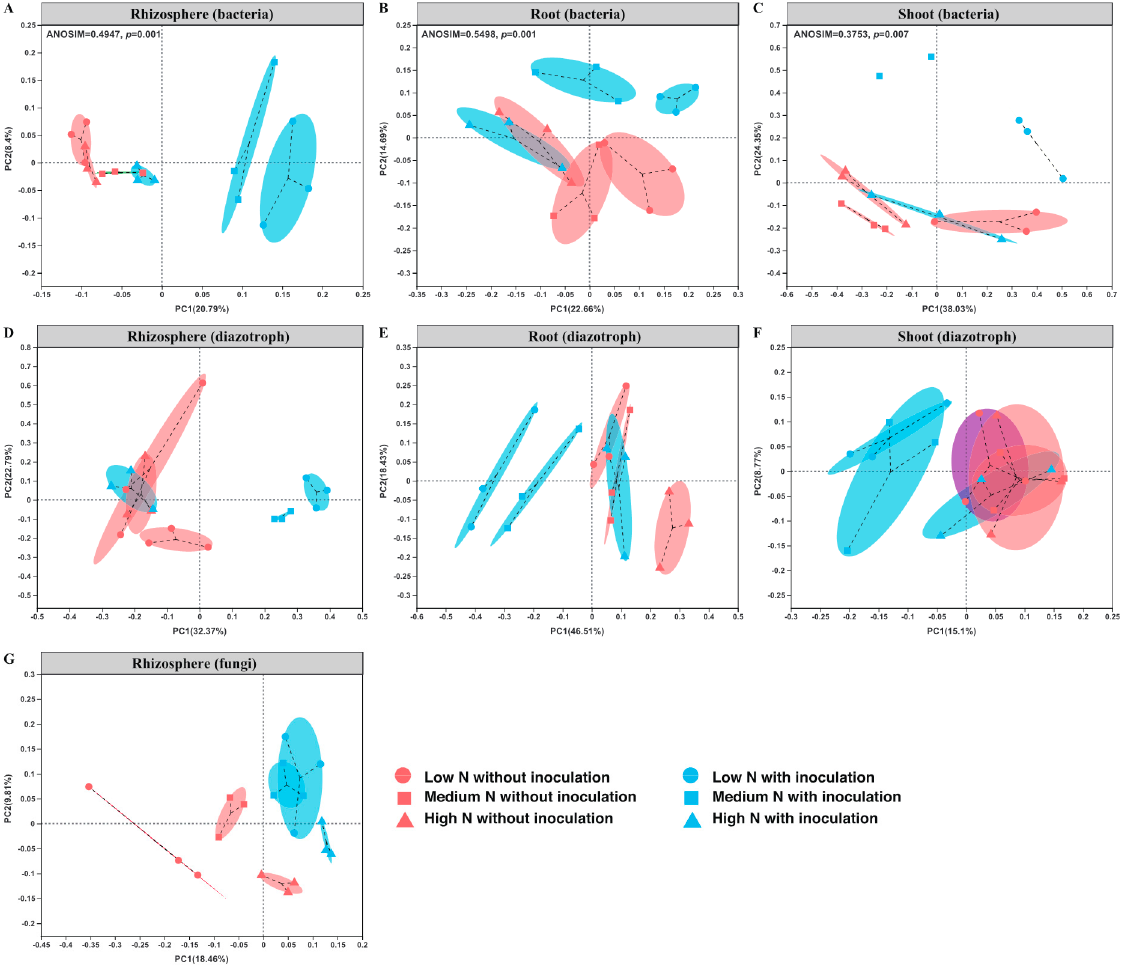
Figure 4. Principal coordinate analysis (PCoA) of the bacterial, diazotrophic and fungal communities in the maize rhizosphere, root and shoot: ( A ) the rhizosphere bacterial community; ( B ) the root endophytic bacterial community; ( C ) the shoot endophytic bacterial community; ( D ) the rhizosphere diazotrophic community; ( E ) the root endophytic diazotrophic community; ( F ) the shoot endophytic diazotrophic community; ( G ) the rhizosphere fungal community. Three independent biological replicates were provided for each treatment except for shoot endophytic bacteria (two independent biological replicates).